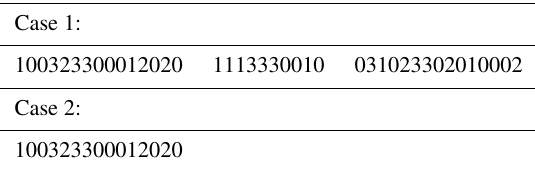
Table B1. The complete database of 1 DOF five-bar DPGT.